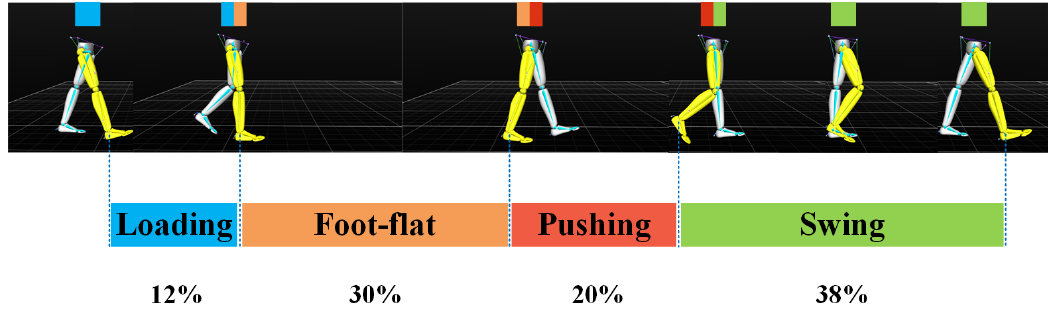
Figure 6. The fundamental temporal parameters: Gait cycle